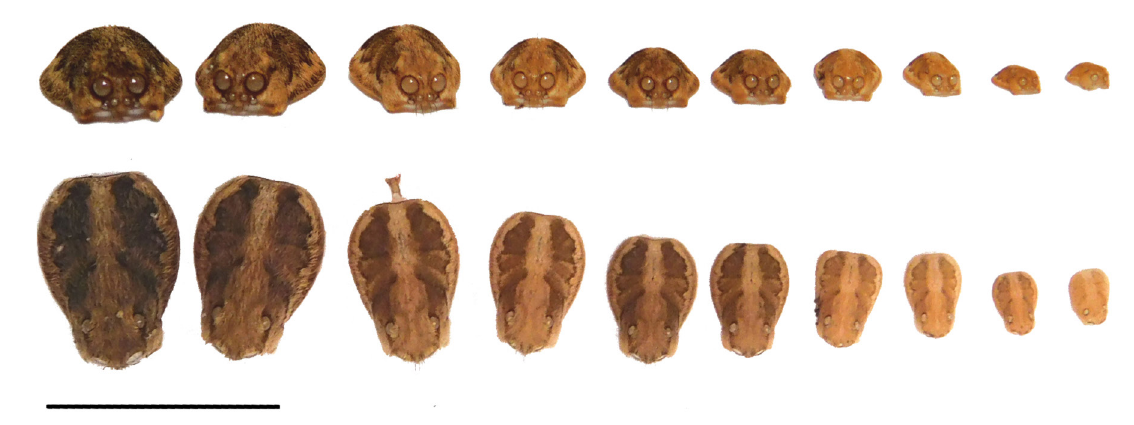
Fig. 26. Lycosa piochardi Simon, 1876, ten carapace molts shed between 9 Mar. 2018–1 Jun. 2020, by a single specimen (HUJ INV-AR20813) in laboratory conditions. Scale bar = 10 mm. Photo by I. Armiach